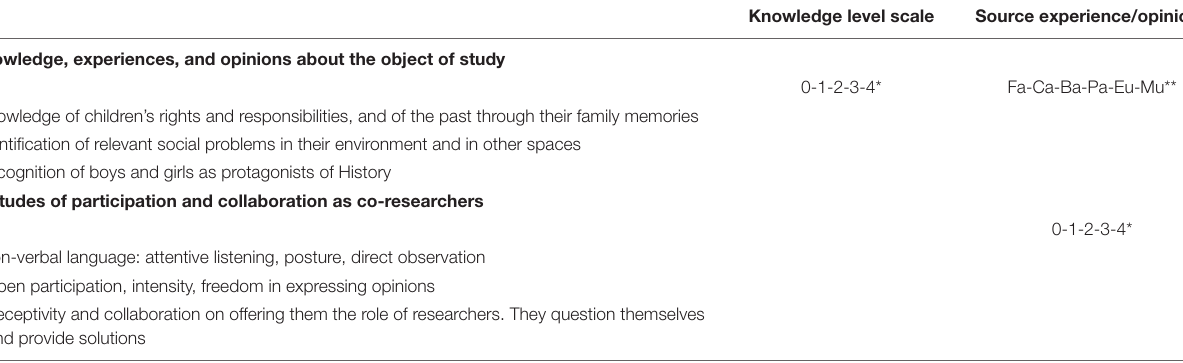
TABLE 3 | Units of meaning